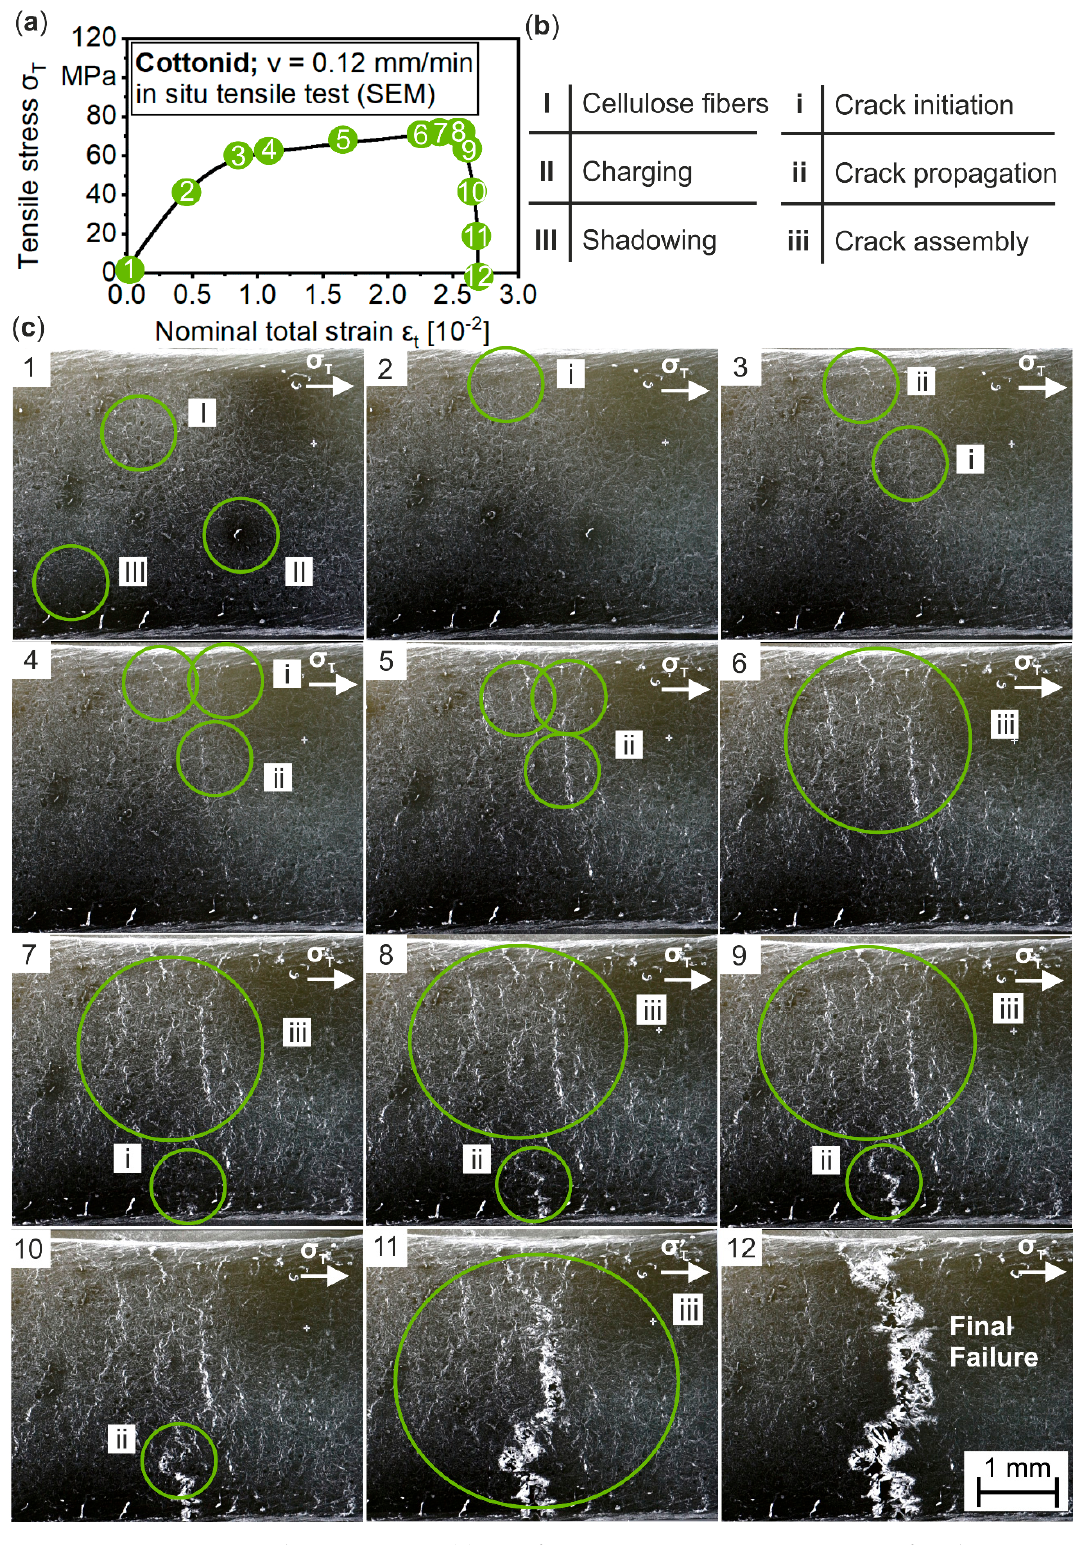
Figure 8. In situ tensile test in SEM: ( a ) significant points in stress–strain curve for obtaining SEM micrographs; ( b ) labelling of characteristic surface areas and occurring damage mechanisms; and ( c ) visualization of damage development on the surface of Cottonid due to quasi-static tensile loading. With increasing tensile stress σ T , first cracks initiate at σ T,2 = 45.62 MPa and a nominal strain of ε n,2 = 0.52 × 10 − 2 at the end of the quasi elastic area (2, i) from imperfections, in this example, in the